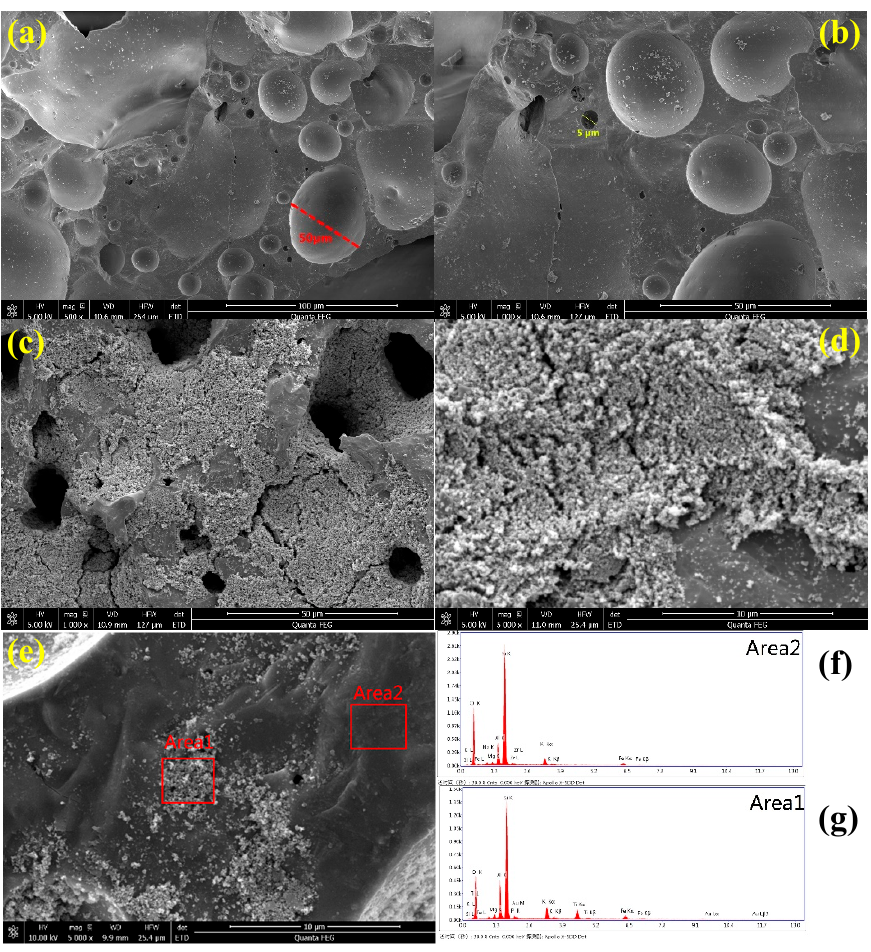
Figure 4. Surface morphology and EDS of CS and PCS; ( a , b ) surface morphology of CS-1.25~2.35; ( c , d ) surface morphology of PCS (4PCS-1.25~2.35); ( e – g ) surface morphology and EDS patterns of PCS